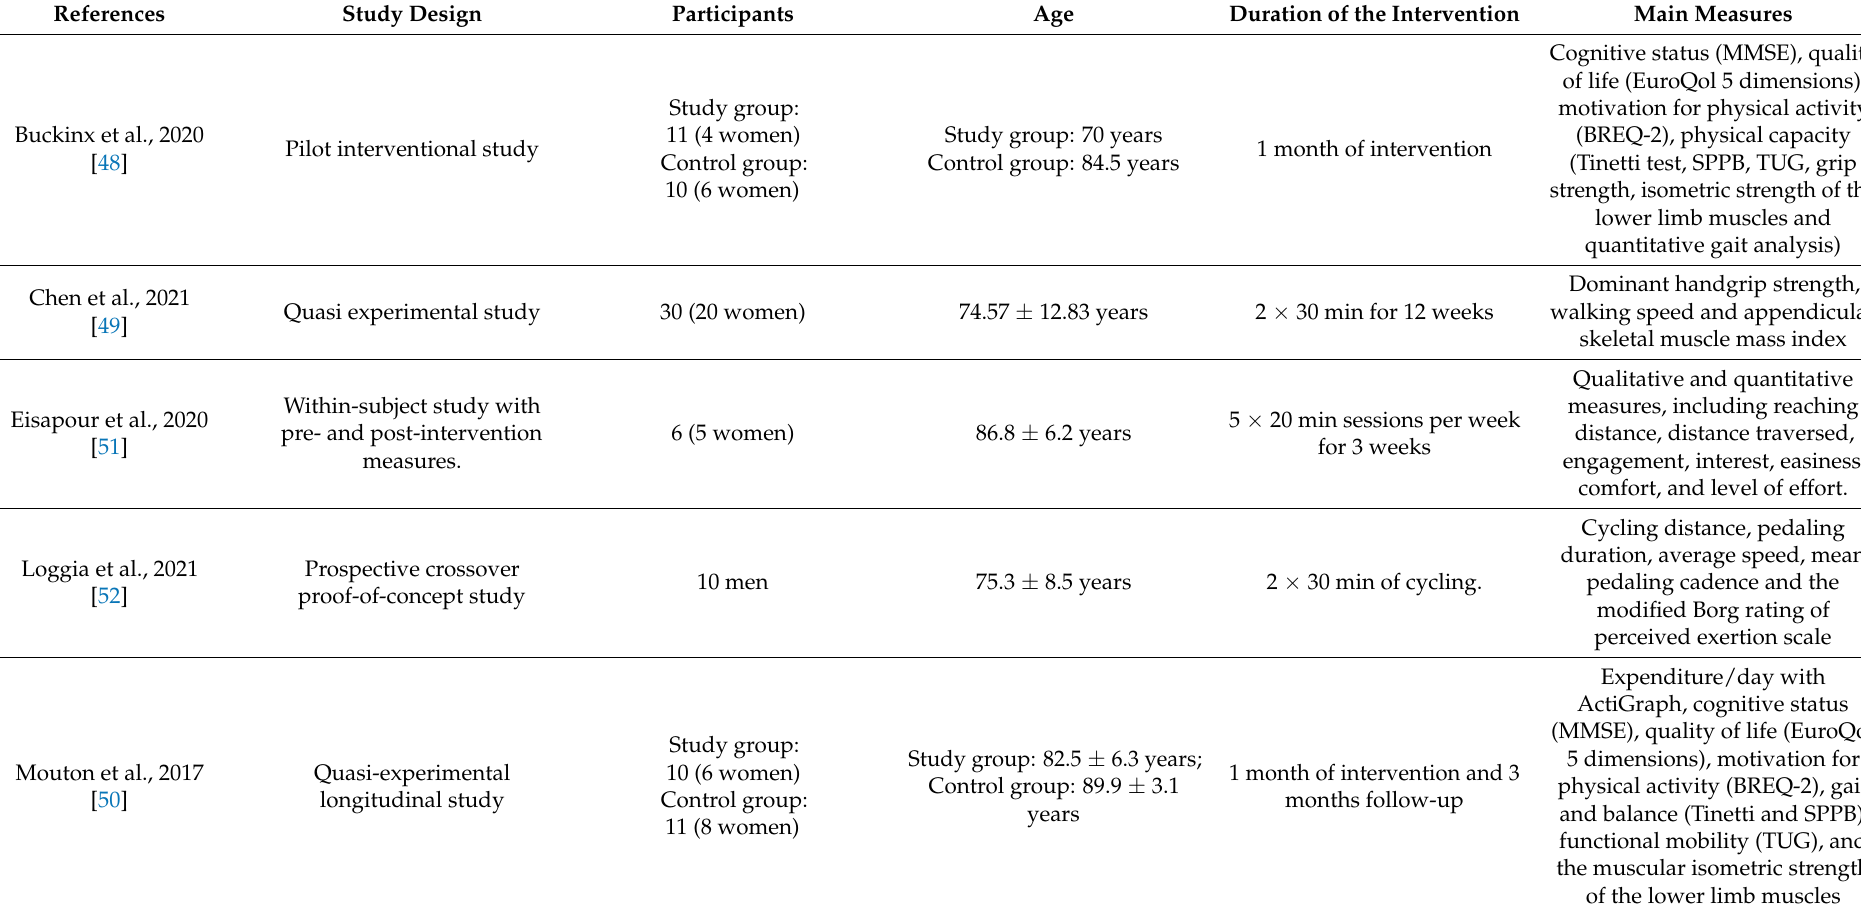
Table 1. Characteristics of the studies included in the